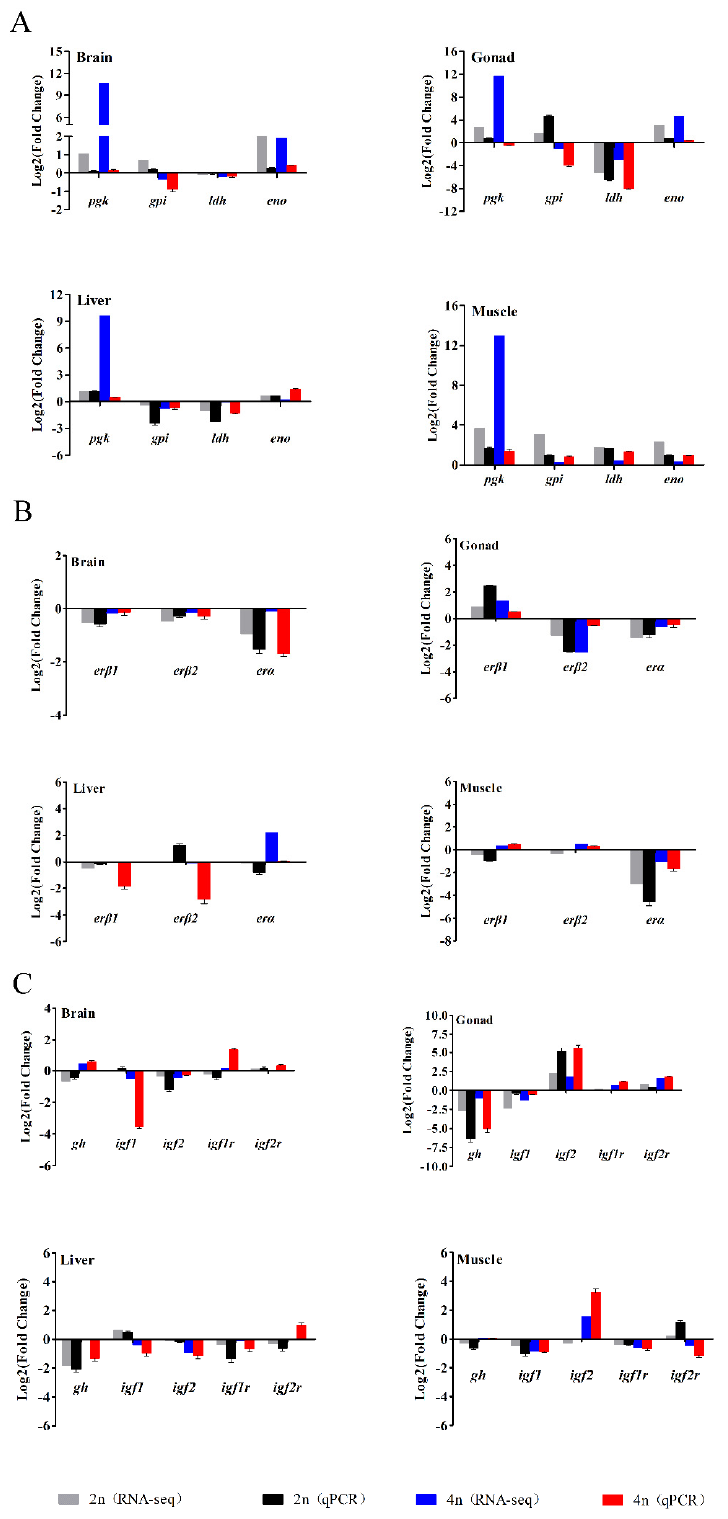
Figure 7. Comparison of the expression profiles of genes involved in the glycolytic pathway. ( A ) Three estrogen receptor genes ( B ) and several reported growth-related genes ( C ) determined by RNA-seq and qPCR in four tissues of female loaches. Each bar represents the expression fold change in a gene compared to that in the male loaches.